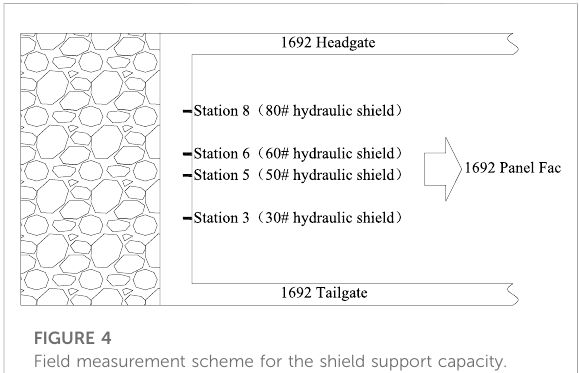
FIGURE 4 Field measurement scheme for the shield support capacity.